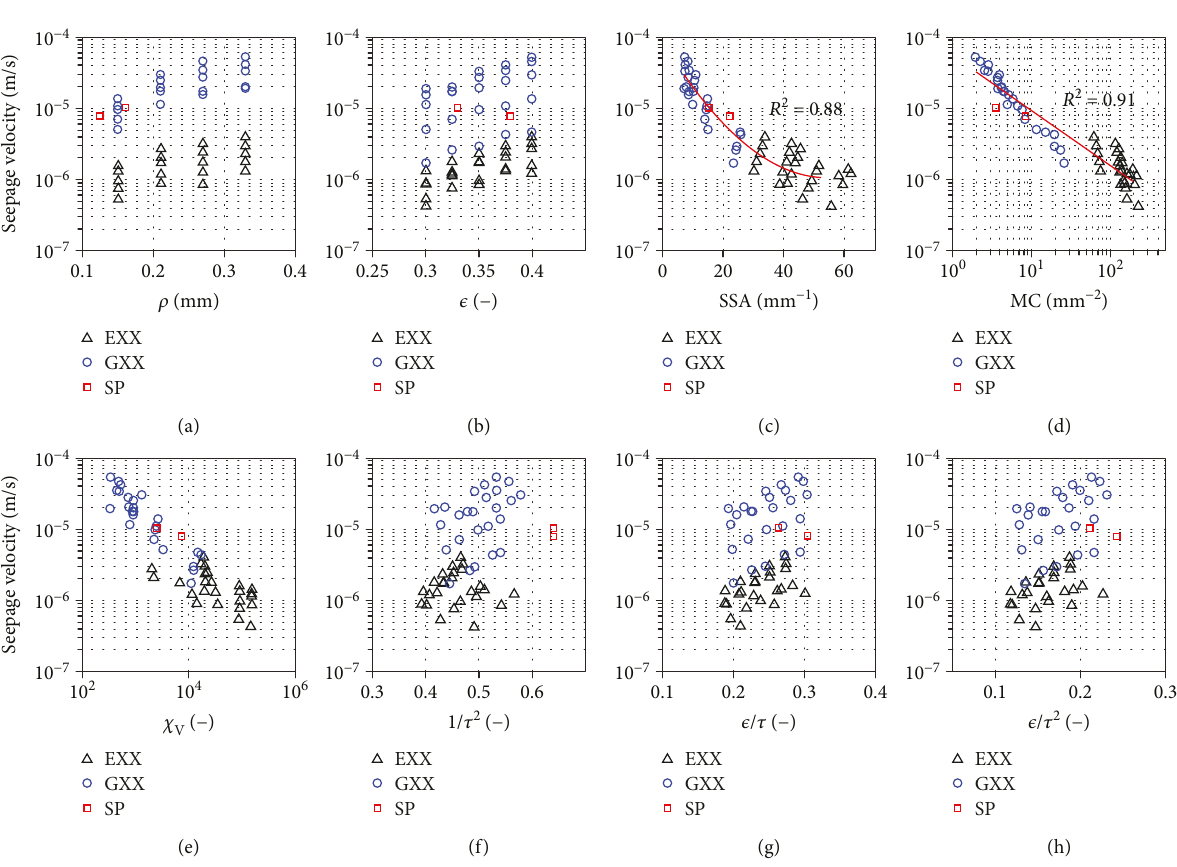
Figure 4: Seepage velocity as a function of correlation length ( ξ ), Minkowski functionals — porosity ( φ ), speci fi c surface area (SSA), mean ) — and literature relationships for e ff ective di ff usivity, 1/ τ 2 , τ 2 / τ , and ϕ / τ 2 , respectively, for curvature (MC), and Euler number ( χ V generated porous media (black triangles and blue circles for exponential (EXX) and Gaussian (GXX) variogram models, respectively) and scanned sandpacks (SP) (red squares). The coe ffi cient of determination ( R 2 ) associated with the fi tting functions for the SSA and MC (red lines) is reported in (c, d).